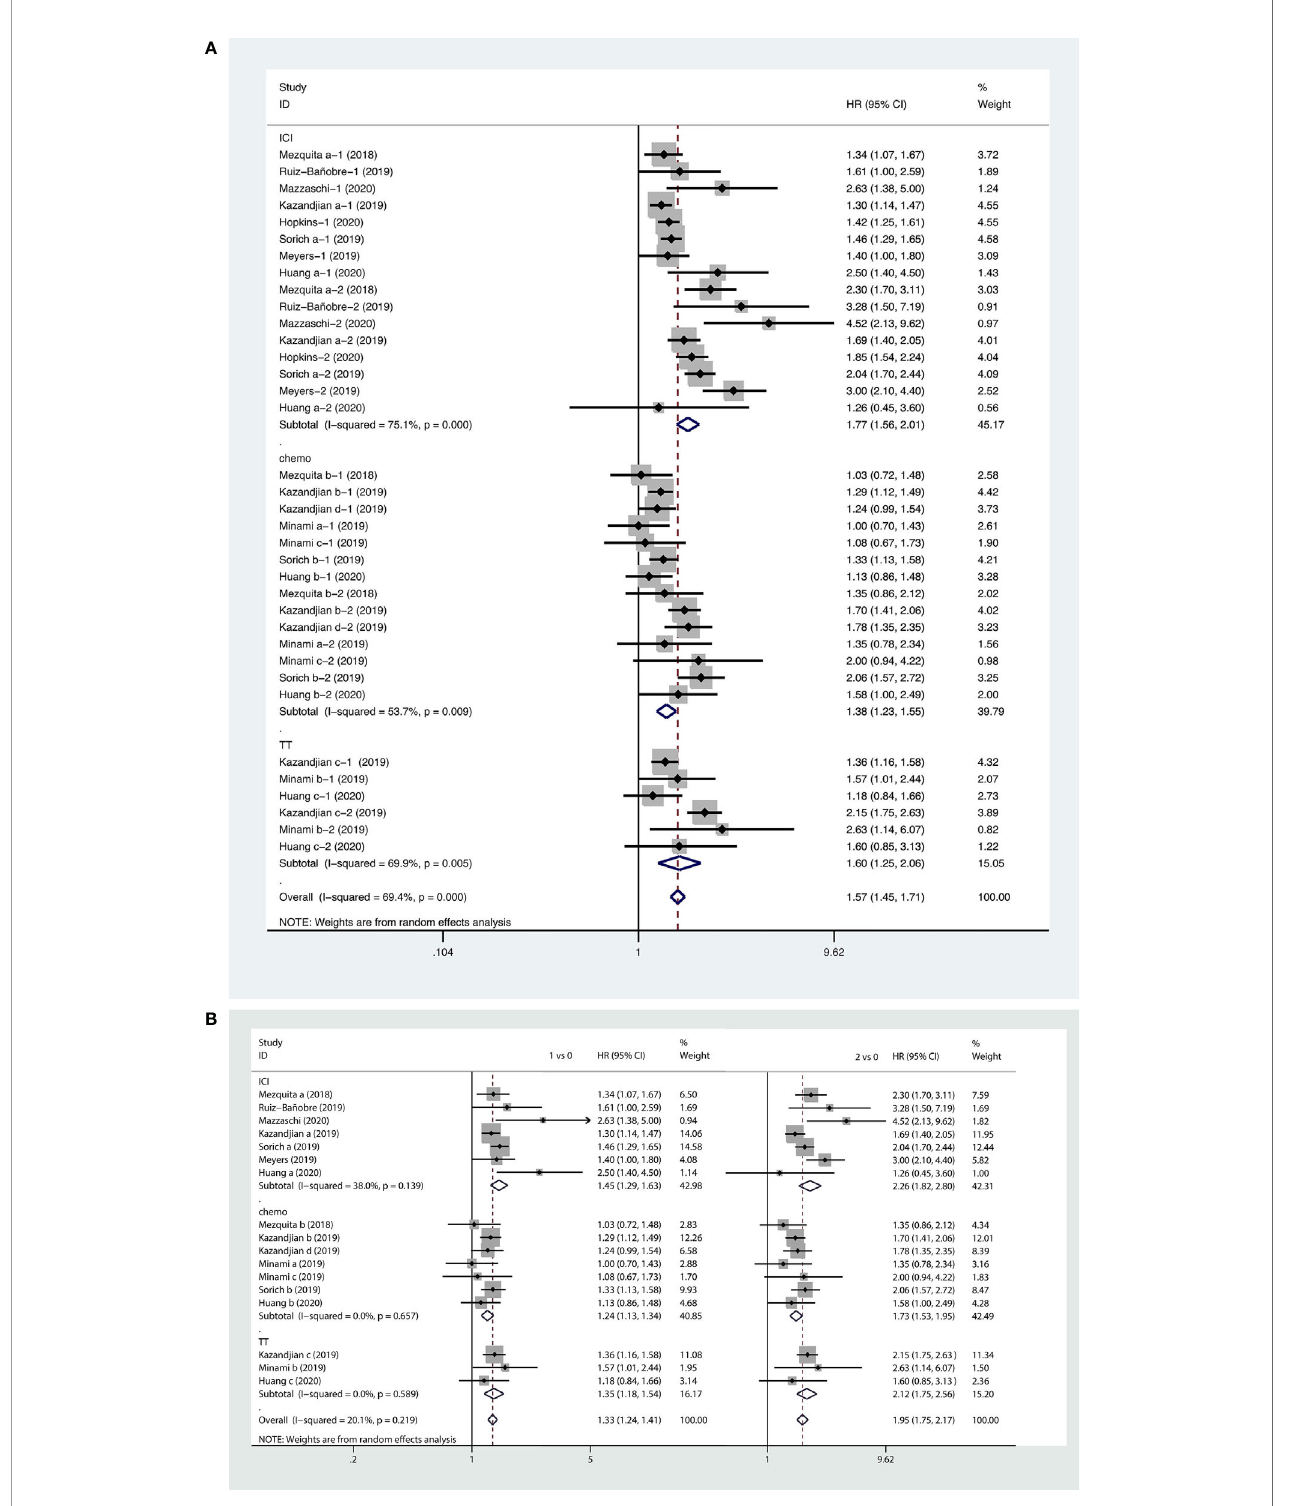
FIGURE 4 | Forest plots of pooled studies examining associations between the lung immune prognostic index (LIPI) score and progression-free survival (PFS), with subgroup analyses categorized by treatment region (A) and LIPI scores (B) ; HR, hazard ratio; CI, con fi dence interval; LIPI score of 1 vs. 0: intermediate versus good; LIPI score of 2 vs. 0: poor versus